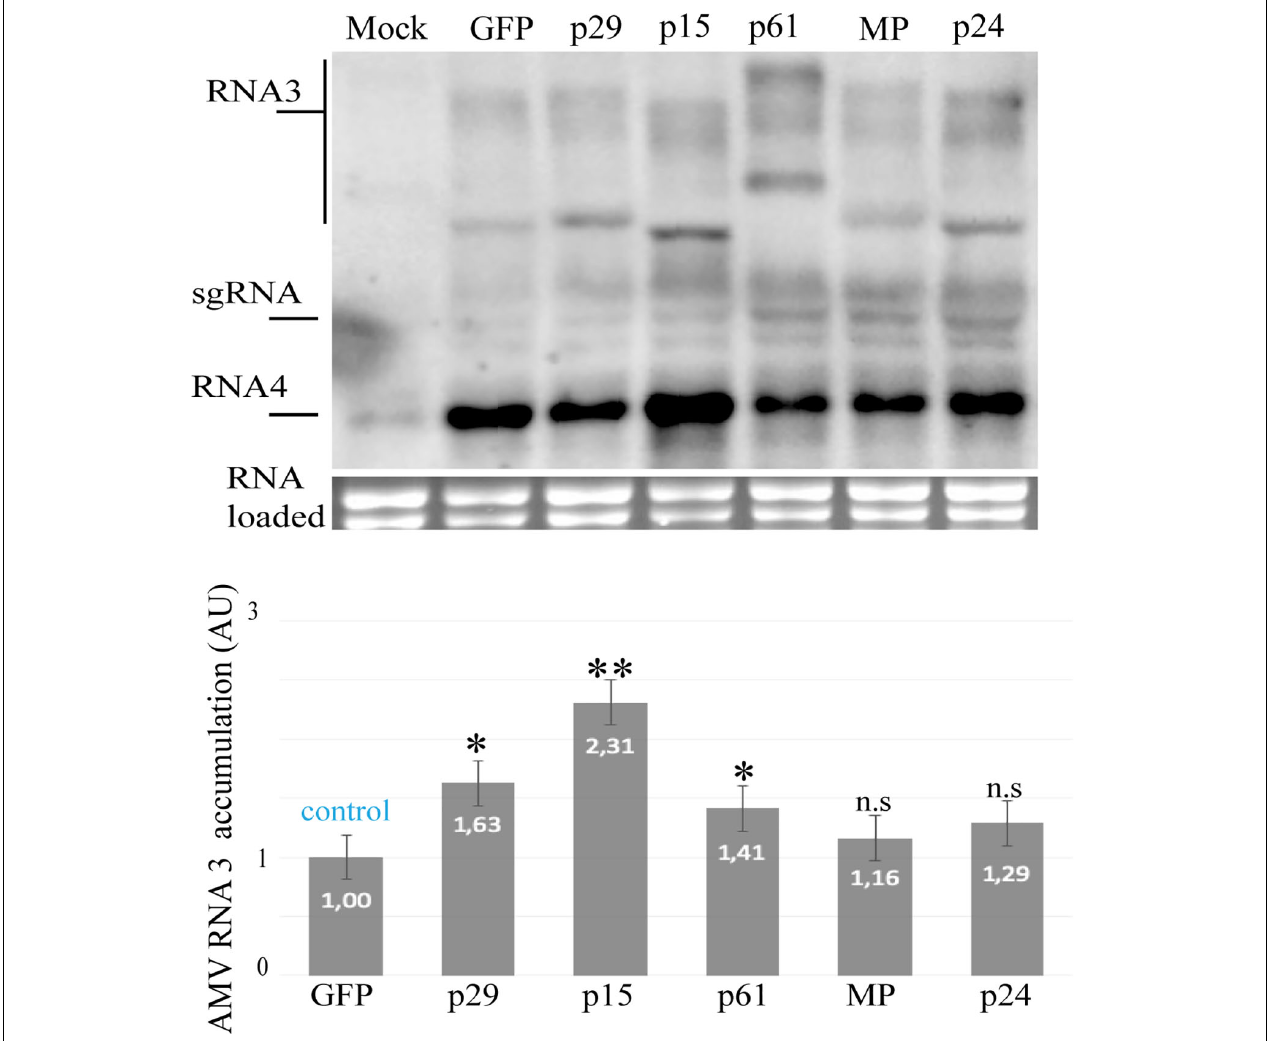
FIGURE 3 | Northern blot analysis of the accumulation of AMV RNA 3 RNA in P12 protoplasts at 16 h post-inoculation, using a dig-riboprobe complementary to the 3’UTR of the AMV. Transcripts correspond to the AMV RNA 3 derivative carrying the p29, p15, p61, MP, and p24 proteins of CiLV-C and GFP protein (negative control). Mock corresponds to the non-infected P12 plant. The localization of RNA 3 and subgenomic RNAs (sgRNA) are indicated. The graph represents the relative accumulation of AMV RNA 3, referred to the construct carrying the GFP from the average of three independent experiments. The value of the averages obtained from the band quantification was normalized in relation to the respective negative control (GFP). The bands were quantified using the ImageJ version 2.0cr software with ISAC plugin and error bars represent standard deviation. Statistical analysis were done using Student’s t -test. Black asterisks ( ∗ ) indicate significantly increased viral accumulation compared to the control. ∗∗ , p < 0.01; ∗ , p < 0.05; n.s, no significant difference. P -values were obtained from pairwise comparations between control vs. viral